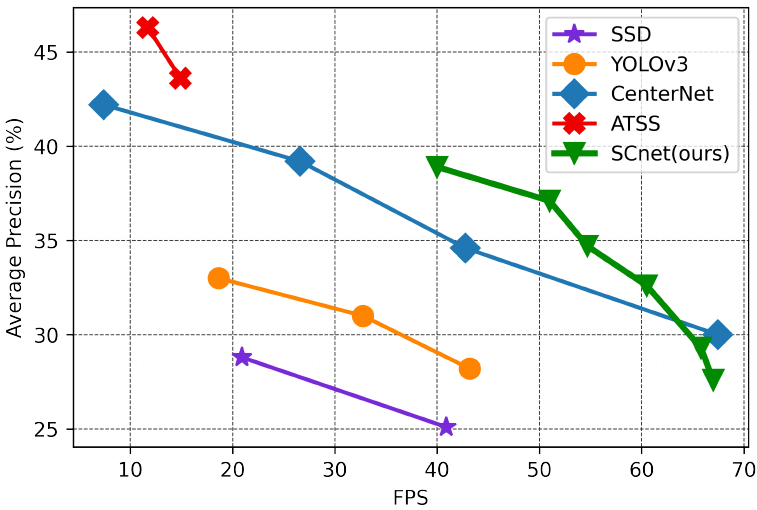
Figure 10. FPS vs. Average Precision on COCO test-dev. SCNet lags behind ATSS and CenterNet in terms of accuracy but is superior in speed. The proposed SCNet exhibits good speed-accuracy trade-off compared with other